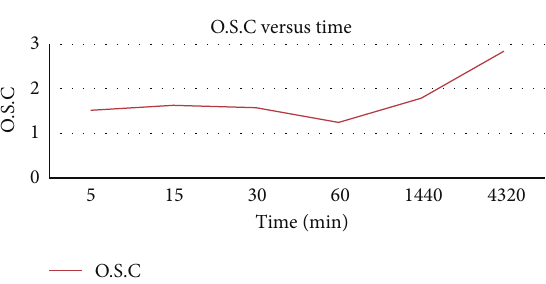
Figure 6: Oil sorption capacity versus time